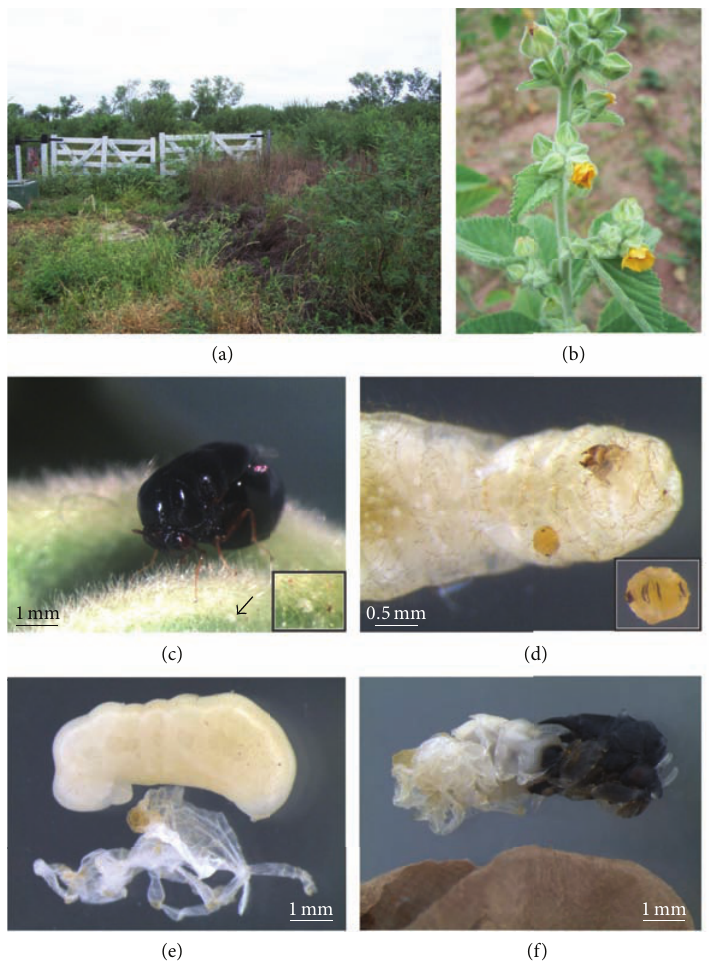
Figure 3: Biology and immature stage of Galearia latreillei : (a) habitat; (b) Sida cordifolia ; (c) female of G. latreillei ovipositing on leaf of S. cordifolia (eggs indicated and magnified); (d) prepupa parasitized (1st instar larva indicated and magnified); (e) third instar (with remains of ant pupa); (f) pupa extracted from ant cocoon (male,